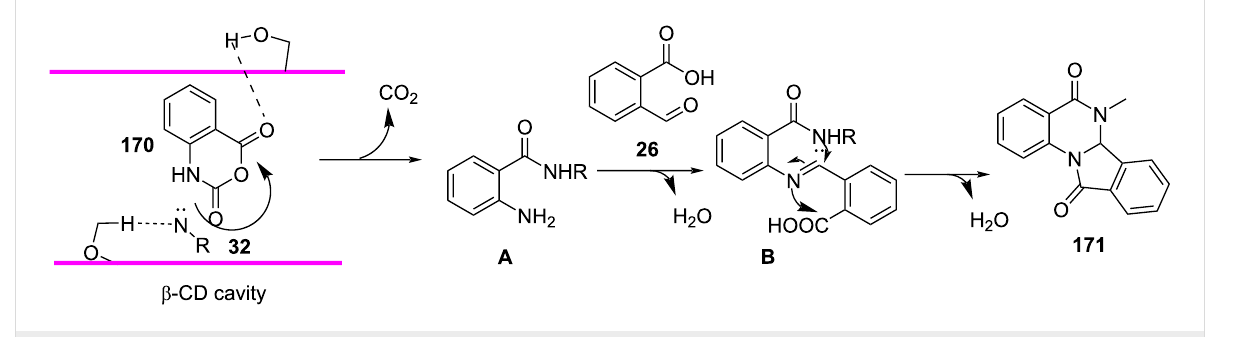
Scheme 72: Proposed mechanism for synthesis of